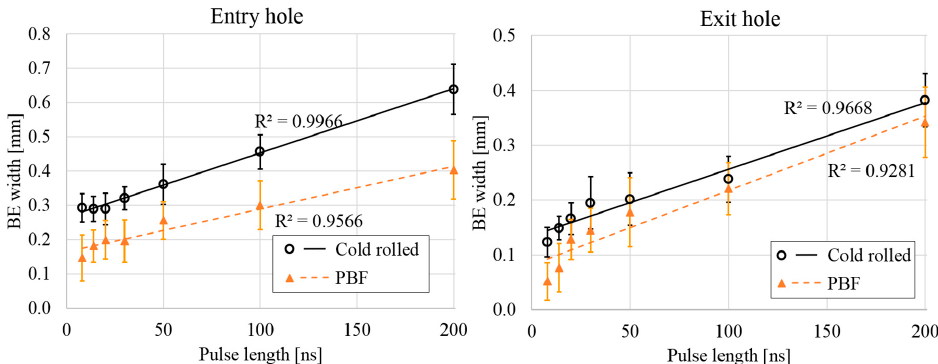
Figure 8. Measured BE widths for the entry and exit holes.